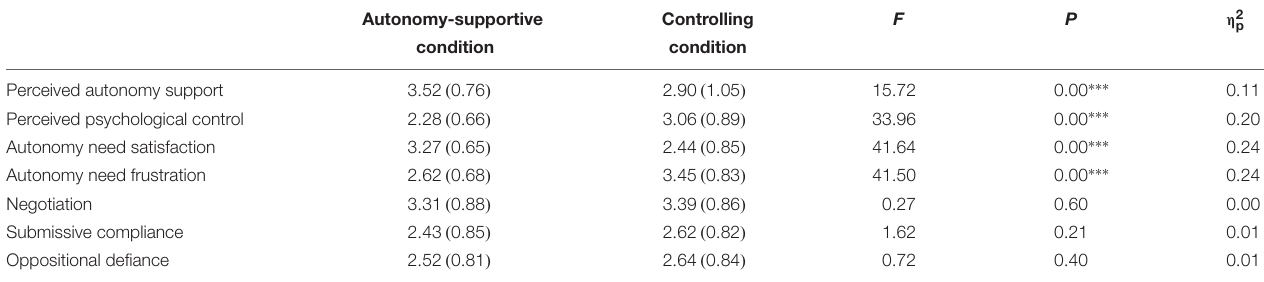
TABLE 2 | Means and standard deviations for the experimental conditions.